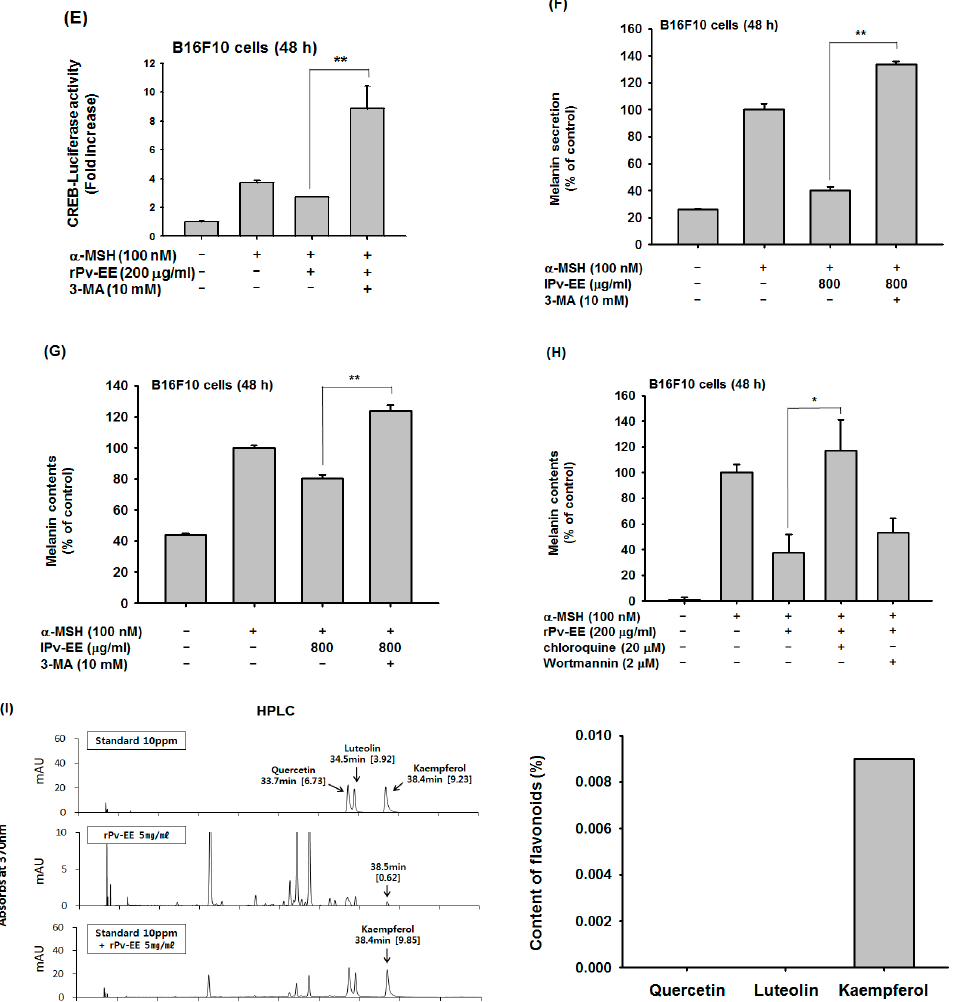
Figure 4. E ff ect of ethanol extract of Patrinia villosa (Pv-EE) on autophagy. ( A – C ) Levels of total LC3B, p62, and β -actin proteins were determined in B16F10 cells using the total antibodies for each protein. ( D , E ) The promoter binding activity of the transcription factor CREB was analyzed using a reporter gene assay. B16F10 cells were transfected with plasmids driving the expression of CREB-Luc (1 µ g / mL) and β -gal (as a transfection control). After 24 h, some of the cells were treated with 100 nM α -MSH and lPv-EE (800 µ g / mL) or rPv-EE (200 µ g / mL) or 3-MA (10 mM) for 48 h. Luciferase activity was measured using a luminometer. ( F – H ) The levels of melanin secretion and contents in B16F10 cells treated with α -MSH (100 nM) in the presence or absence of lPv-EE (800 µ g / mL) or 3-MA (10 mM) or chloroquine (20 µ M) or Wortmannin (2 µ M) for 48 h were then determined. ( I ) The phytochemical profile of rPv-EE was analyzed by HPLC using standard compounds (quercetin, luteolin, and kaempferol). ** p < 0.01 compared to the normal group and * p < 0.05 compared to the control group.